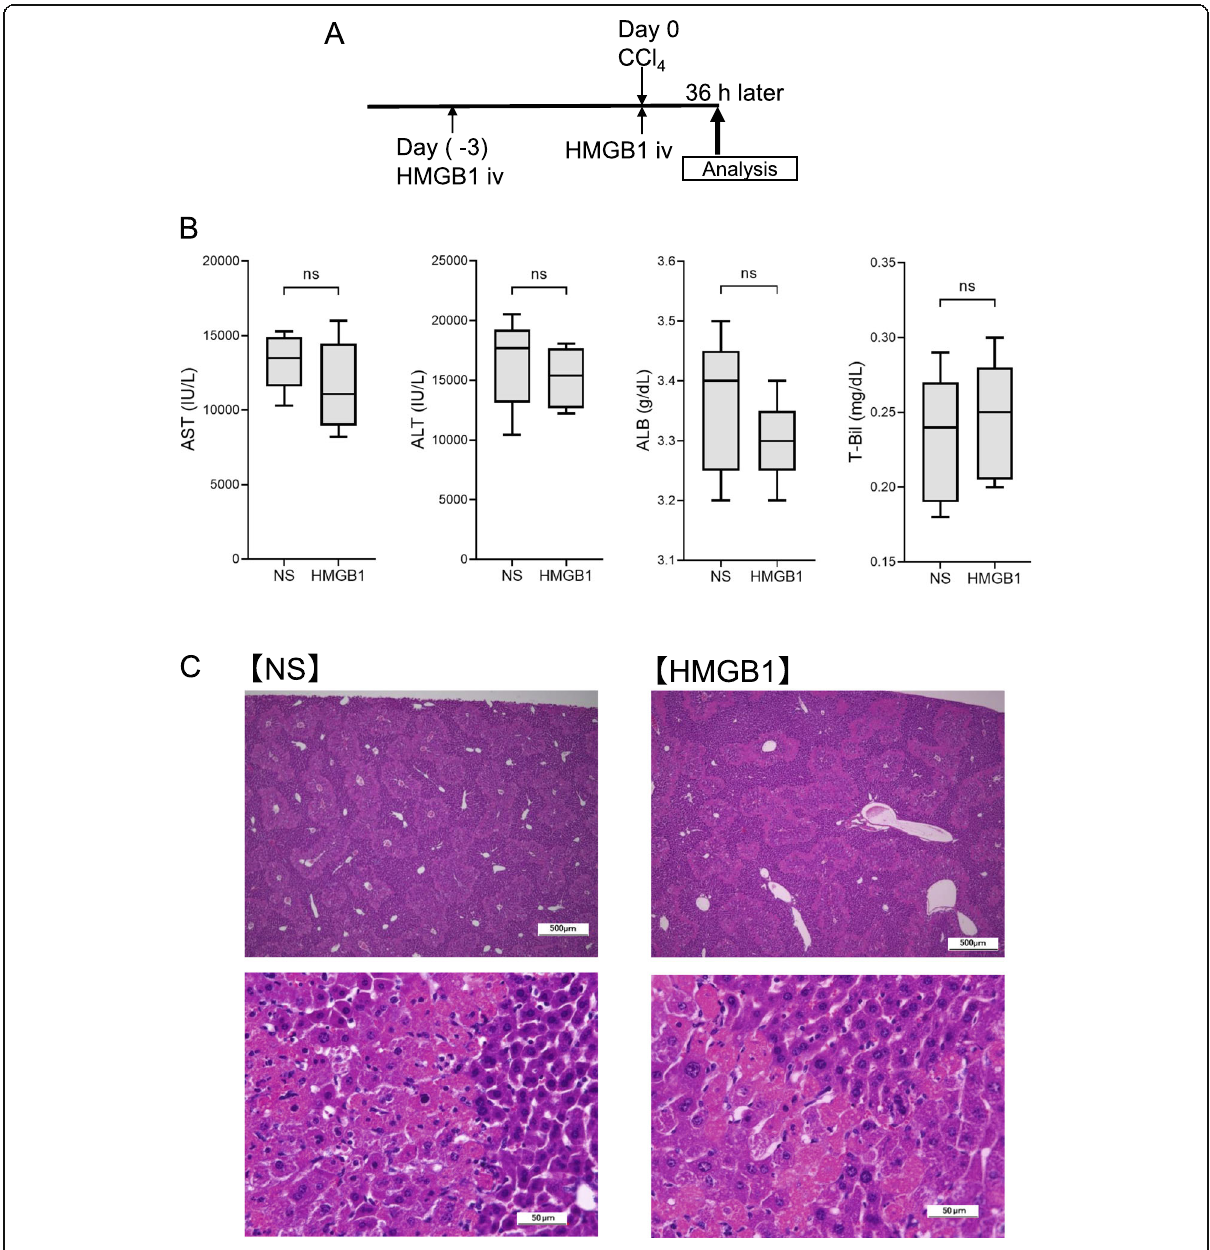
Fig. 3 Therapeutic effects of HMGB1 in a one-time CCl 4 -induced liver damage model. A Schematic of this experiment. B Serum levels of AST, ALT, ALB, and T-Bil. C Hematoxylin and eosin staining (upper panels, scale bar = 500 μ m; lower panels, scale bar: 50 μ m). n = 8 in each group. Data are presented as means ± standard deviations. ns, not